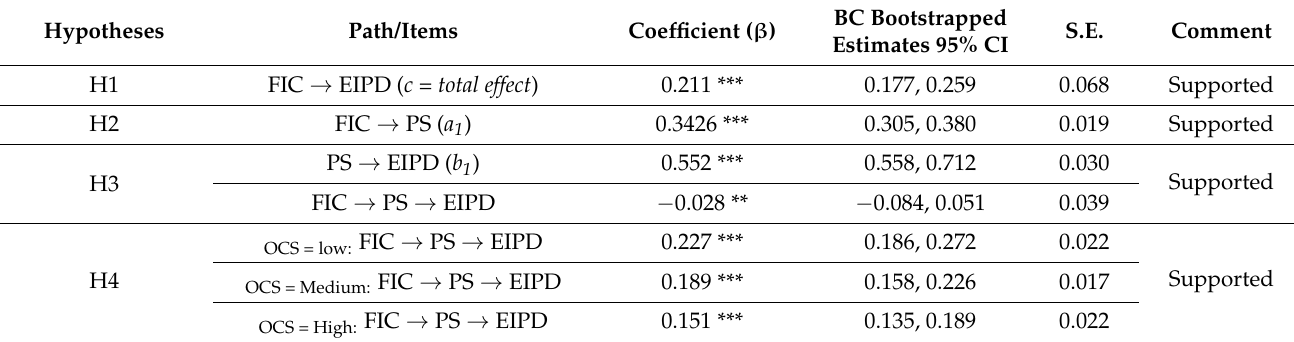
Table 6. Results of direct and indirect